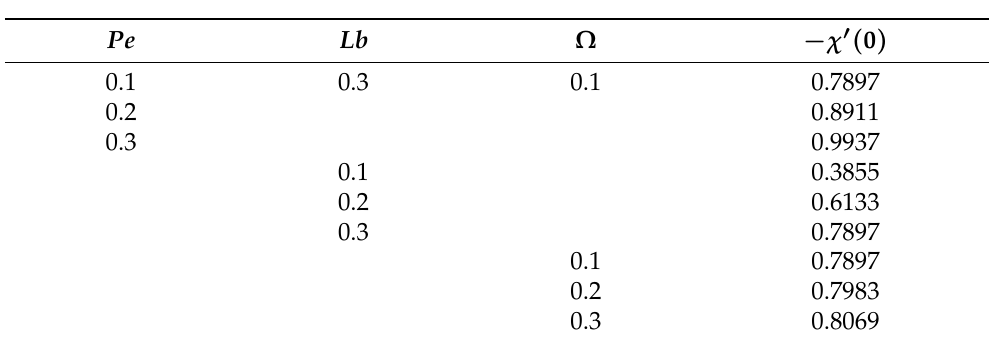
Table 6. Numerical outcomes for Re